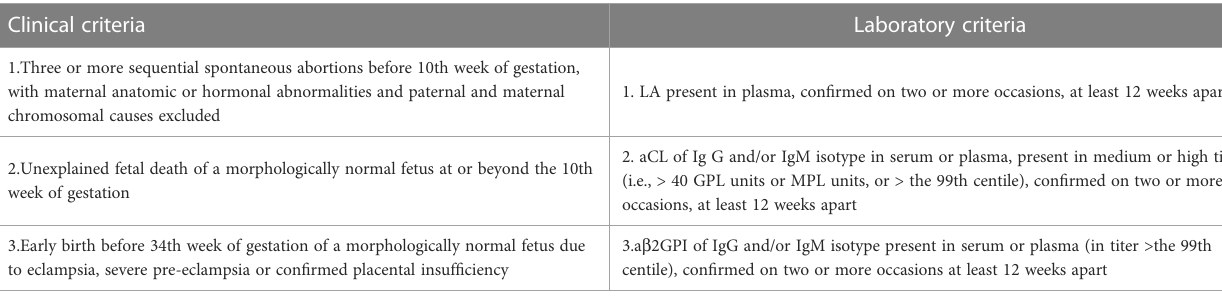
TABLE 1A The international consensus (revised Sapporo) criteria for diagnosis of